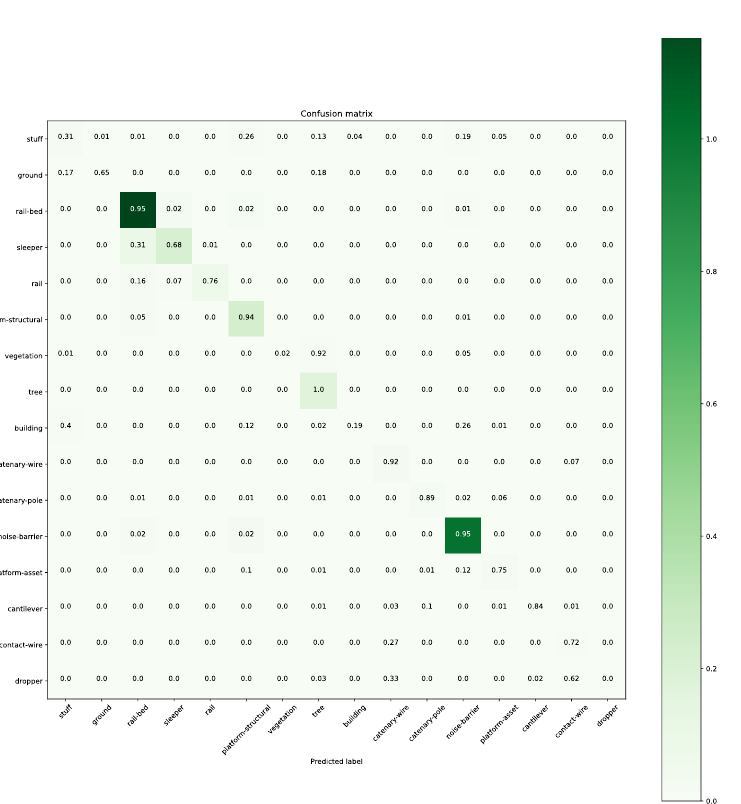
Figure A4. Summary for the 40% validation for step 70. Validation points are picked with means to spacial coverage (KPconv).